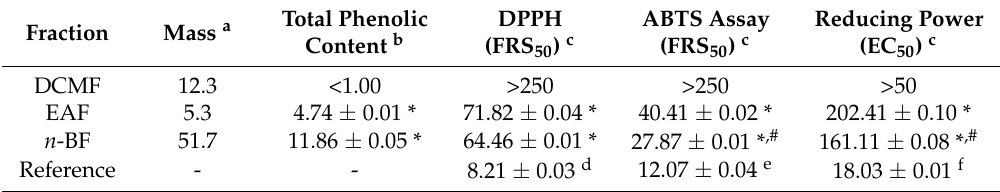
Table Data represent the mean values ± SD of three independent assays performed in triplicate ( n = 3). a % of